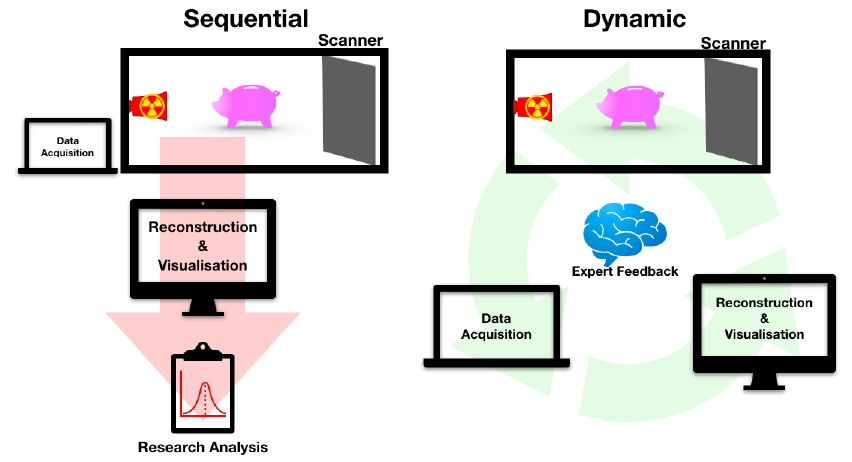
Figure 1. An illustration of the basics of explorative imaging (dynamic) in a tomography setting, with the traditional process of imaging (sequential) included for